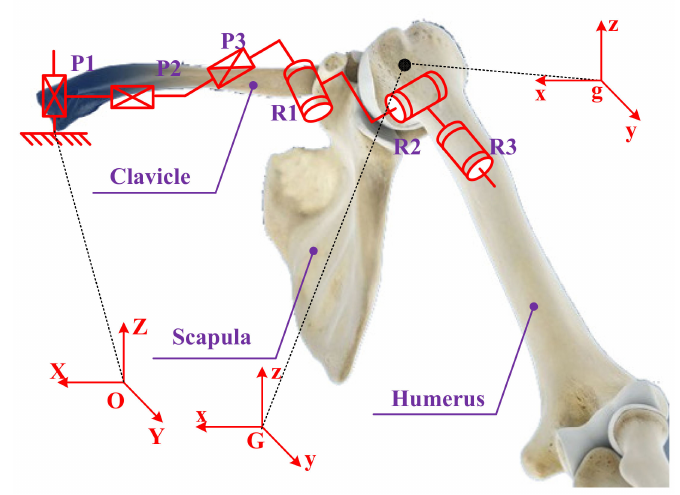
Figure 2. Mechanism model of the shoulder